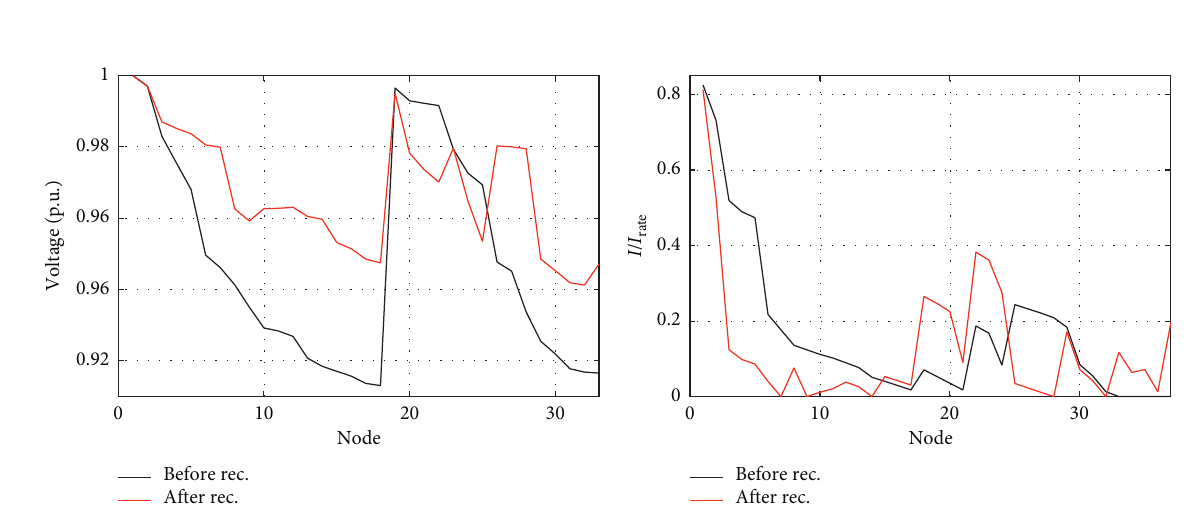
Figure 9: Voltage and current profile obtained for the 33-node system.